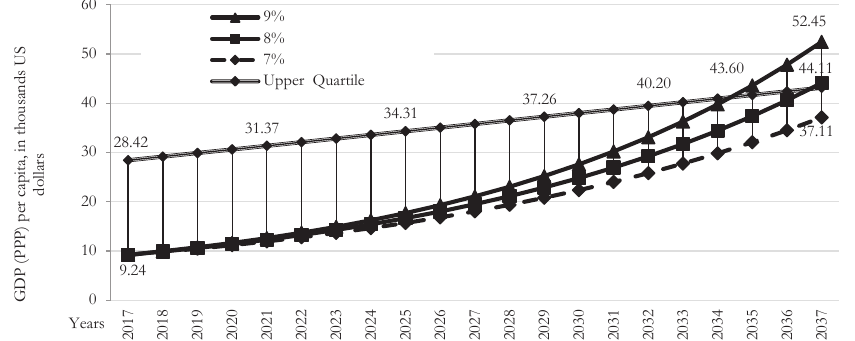
Fig. 14 – Model curves with different growth rates of GDP (PPP) per capita compared to 25% of the richest econo- mies in the world. Source: own